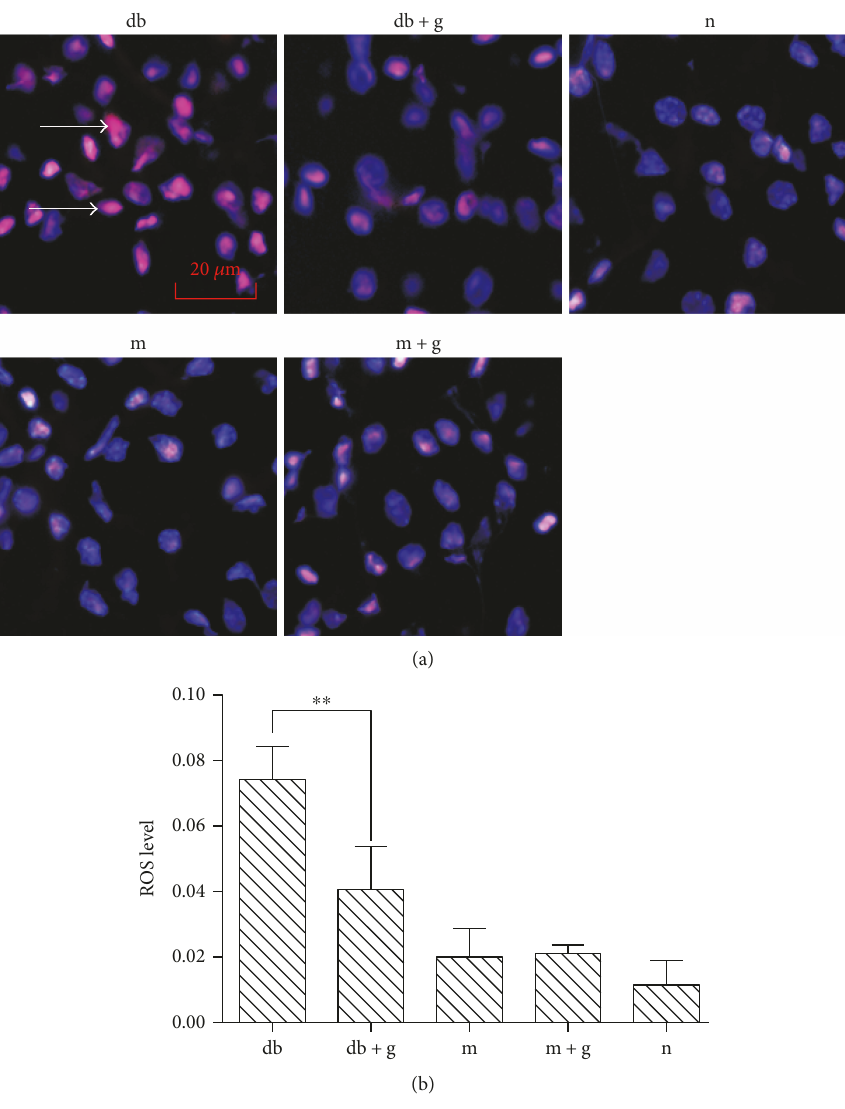
Figure 5: E ff ect of GA on ROS levels in the kidneys of db/db mice. The bar graph demonstrates the increases in ROS production observed in the renal cortex of db/db mice and the antioxidant e ff ect of GA. The lower panels are representatives of the original recorded data. The data were collected from 3 independent experiments and are presented as means ± SD. ∗∗ p < 0 05 compared with the control. One-way ANOVA followed by Tukey ’ s